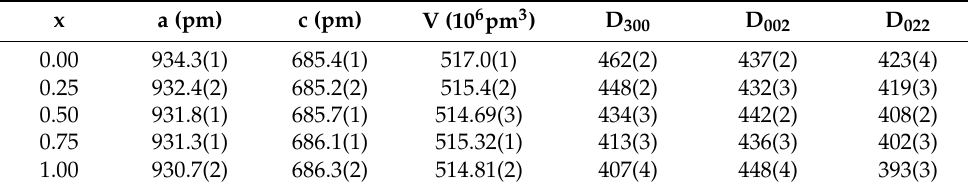
Figure 1. XRD patterns of the synthesized Ca 10 − x K x (PO 4 ) 6 F (2 − 2 x ) (OH) x for 0 ≤ x ≤ 1. Table 1. Lattice parameters, unit cell volume and crystallite sizes for Ca 10 − x K x (PO 4 ) 6 F (2 − 2 x ) (OH) x for 0 ≤ x ≤ 1.